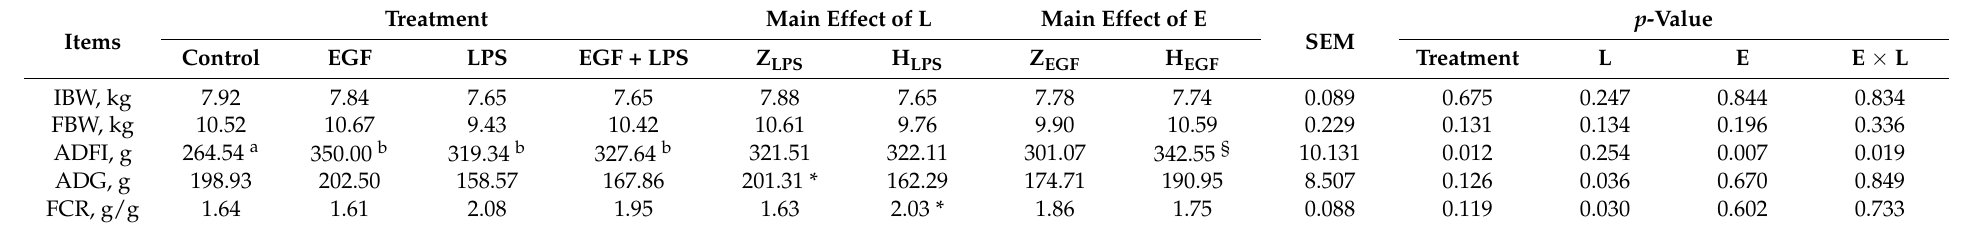
Table 3. Epidermal growth factor (EGF) attenuates the effect of lipopolysaccharide (LPS) on growth performance of early-weaning piglets.